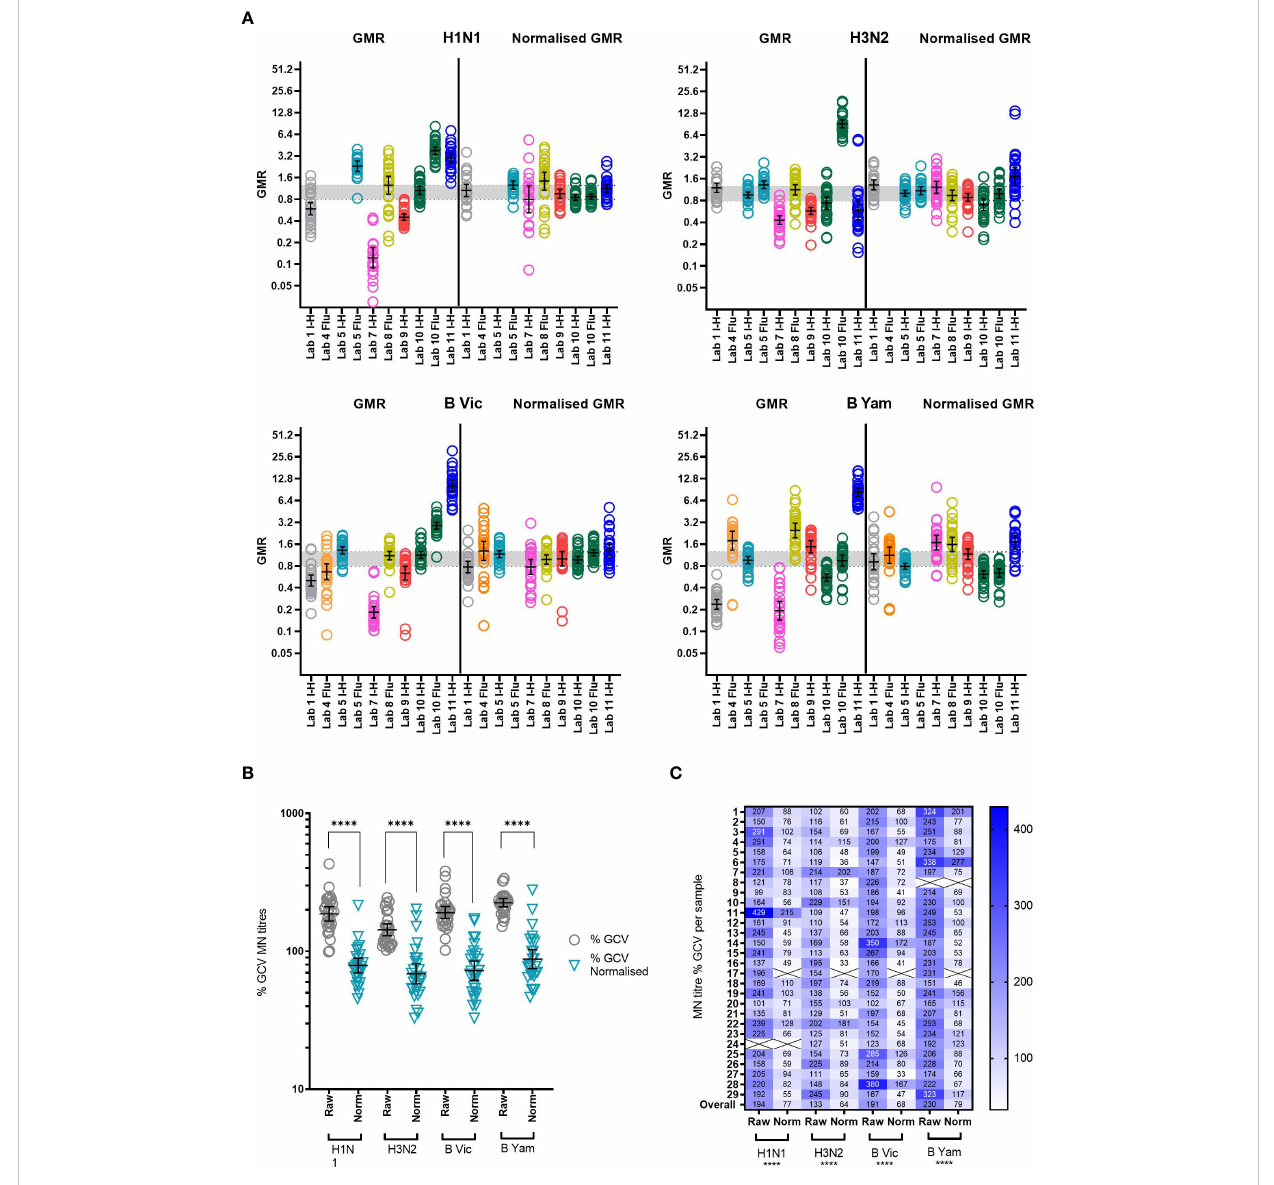
FIGURE 7 Impact of using a study standard on inter-laboratory variation in MN testing. (A) GMR of the MN titre of each sample before and after normalisation using Pool 1 (sample 17) as a study standard. Negative samples (MN GMT <10) were excluded from analysis. Where a laboratory did not return a valid titre for the study standard in each reported run, that laboratory was excluded from analysis. Geometric mean and 95% CI are shown in black. The indicative interval of 0.8-1.25 is shaded in grey. Each laboratory has a unique number and colour in all graphical representation of data. (B, C) %GCV of each sample MN titre before (raw) and after (norm) normalisation using Pool 1 (sample 17) as a study standard. The Wilcoxon matched pairs test was used for statistical analysis (in each case P<0.0001****) Data are shown for each virus tested: H1N1 A/Michigan/45/15-like, H3N2